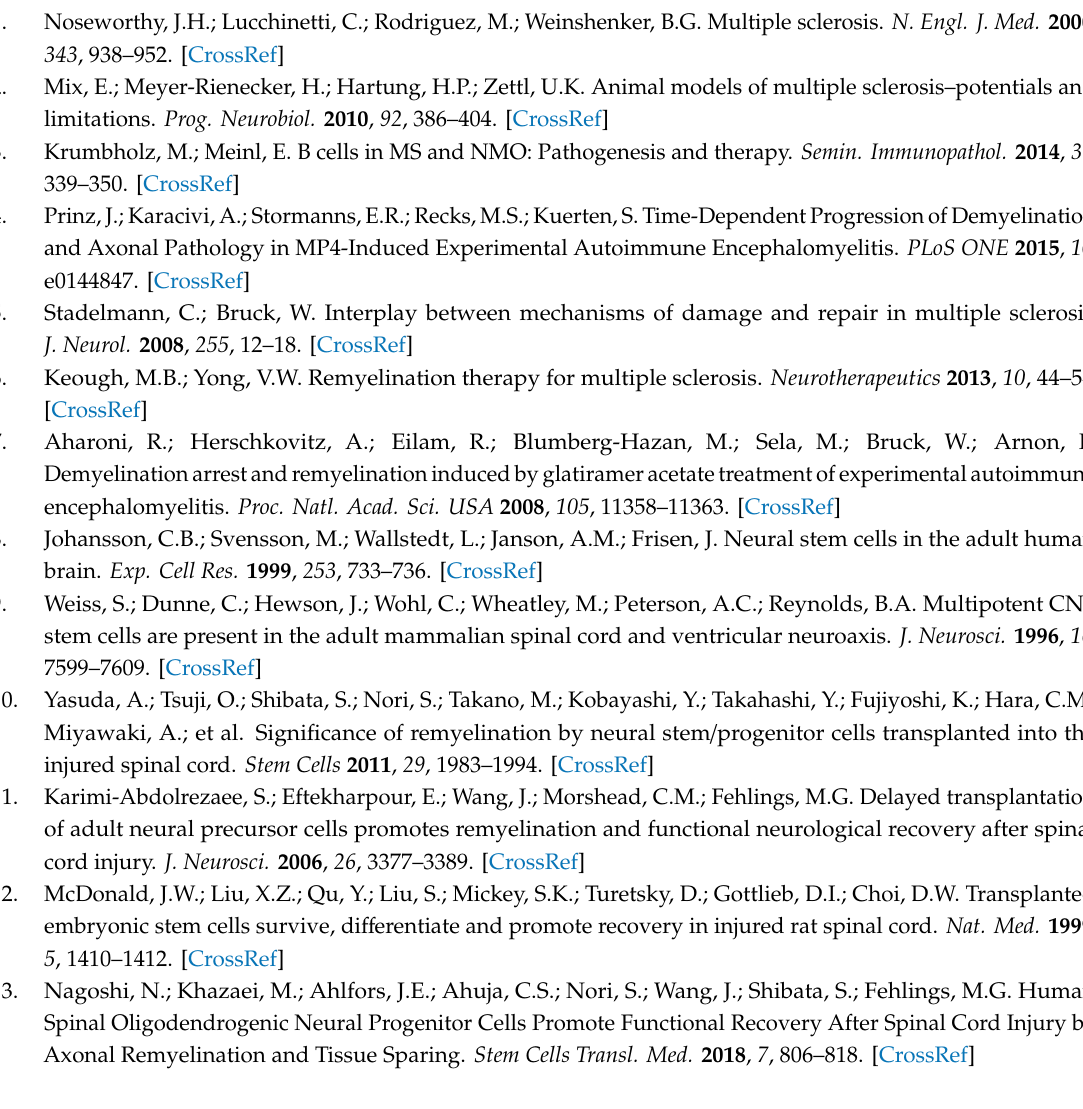
Table S1: Clinical scores of individual mice after MOG